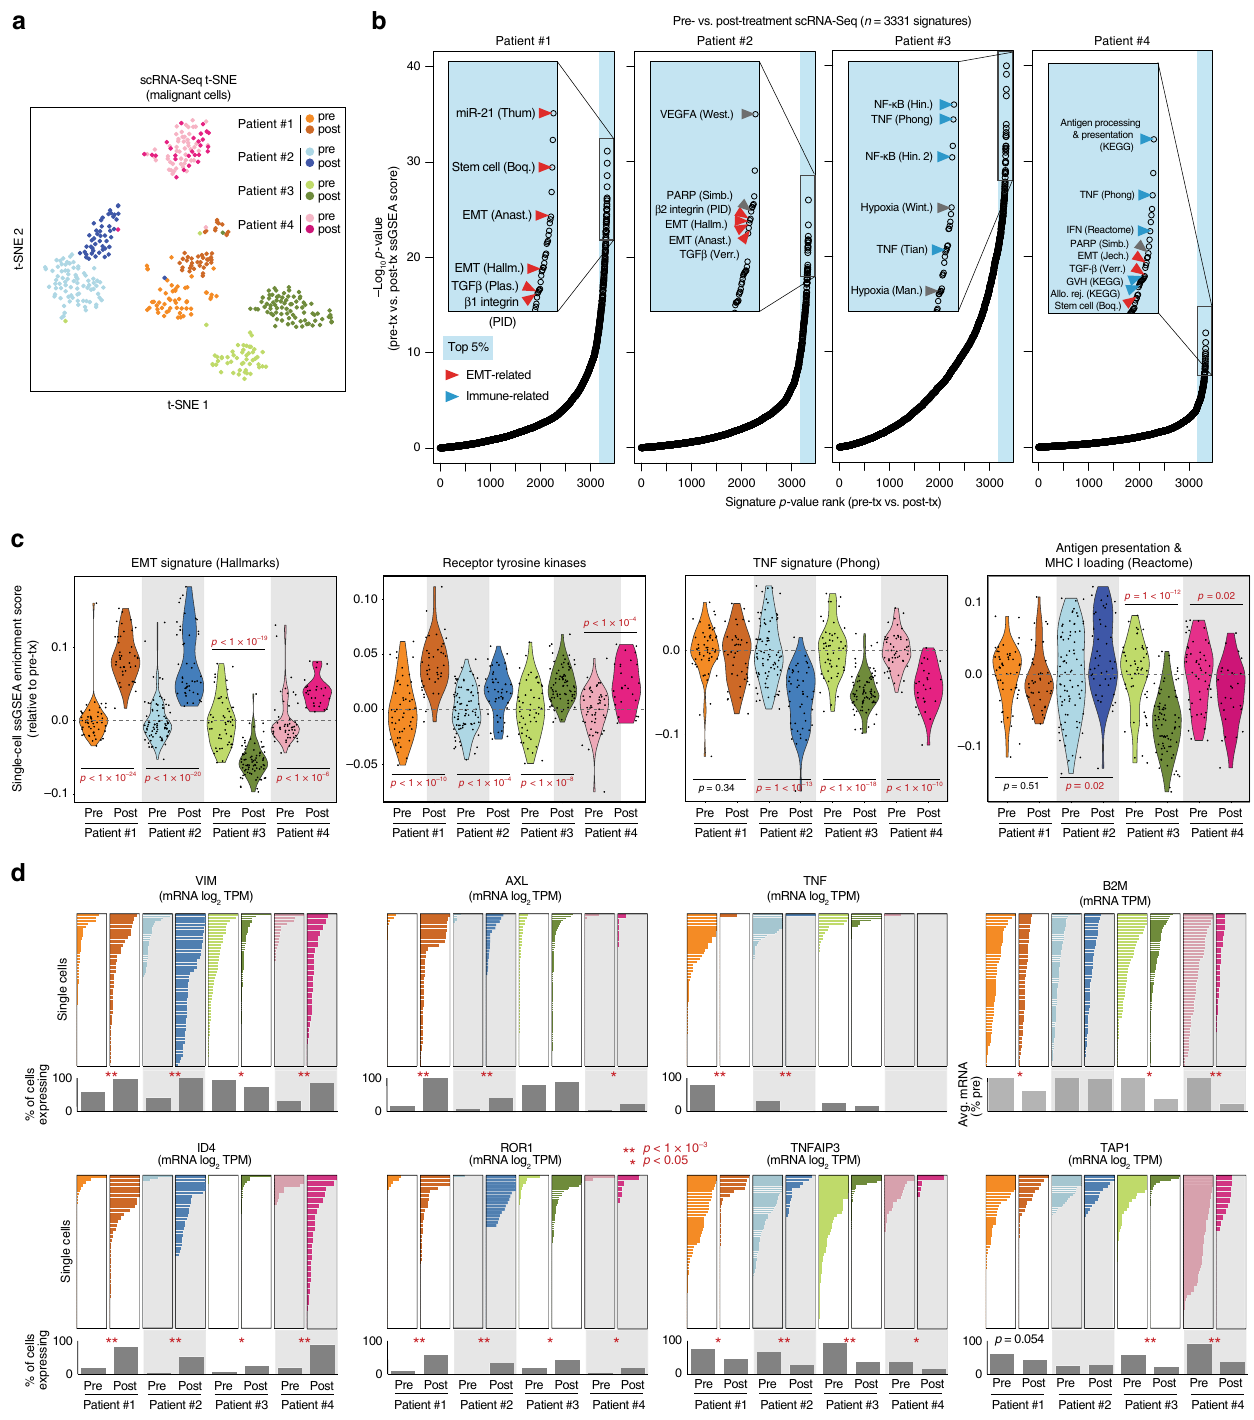
Fig. 5 Single-cell RNA-Seq of pre- and post-treatment breast cancers reveals increased immune-avoidance, EMT, and RTK phenotypes. a t-SNE analysis of 428 individual cells ’ expression pro fi les from pre- and post-treatment breast cancer samples from four patients. b Plots of P -values ( t -test-derived) comparing ssGSEA enrichment scores for 3331 C2 signatures between pre- and post-treatment single cells in each patient. x -axis, P -value ranks (higher ranks are more signi fi cant); y -axis, − log 10 ( P -value). Red arrows, EMT- and stem cell-related signatures; blue arrows, immune-related signatures. c ssGSEA enrichment score (relative to pre-treatment average) violin plots for single cells in each sample for indicated signatures. Each point represents a single cell. P -values are by Student ’ s t -test (two-tailed). d Expression of indicated genes by scRNA-Seq ( x -axis) in individual cells ( y -axis) with percent of cells expressing each gene or average expression indicated below in gray bars. P -values are by two-sample proportion test. * P < 0.05. ** P < 1 × 10 − 3 . x -axis scales all begin at zero (left) and are the same within patients for each